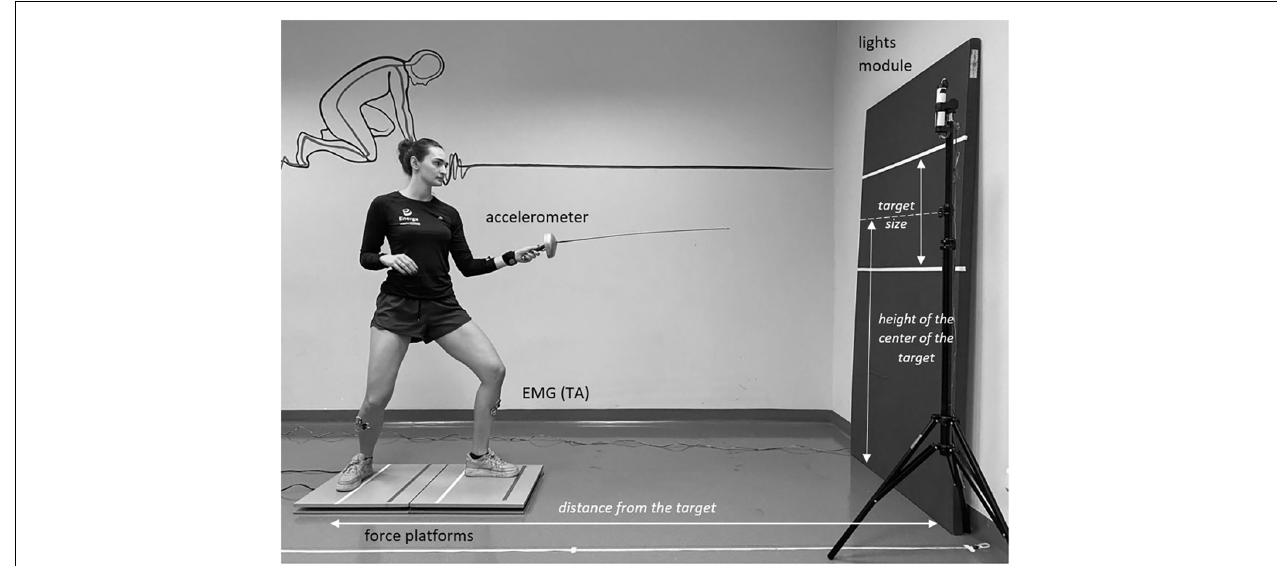
FIGURE 1 | Experimental